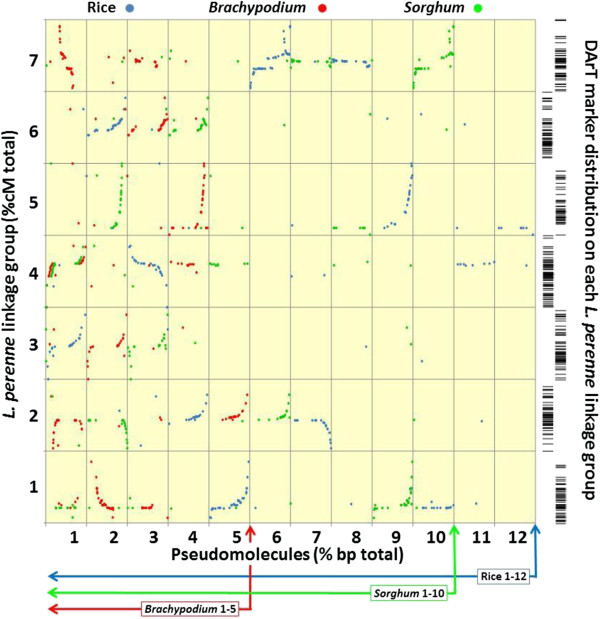
Comparative genomic relationships between L. perenne, B. distachyon, S. bicolor and rice relative to DArT marker distribution. Scatter plot illustrating the conserved syntenic relationships between the relative position of gene-based markers on the L. perenne linkage groups (Lp1 study), the physical position of their most probable sequence alignments on the B. distachyon, S. bicolor and rice pseudomolecules and the genetic distance spanned by the DArT markers mapped to each L. perenne linkage group. The position of the S. bicolor markers from pseudomolecule 1 which align with genetic markers which map to L. perenne linkage group 4 are offset slightly to avoid direct overlap with the B. distachyon alignments to the same linkage group. Figure adapted from King et al. [22].